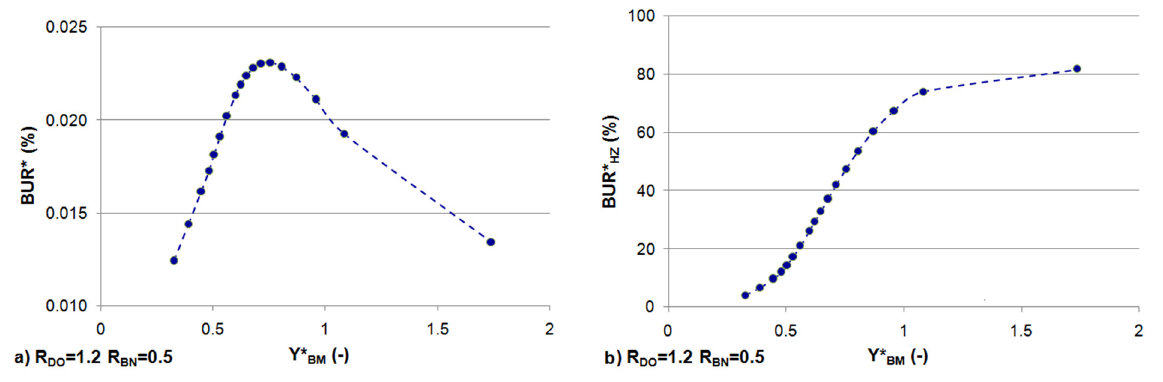
Figure 4. ( a ) Stream, BUR * , and ( b ) hyporheic, BUR * HZ , dimensionless BUR , as a